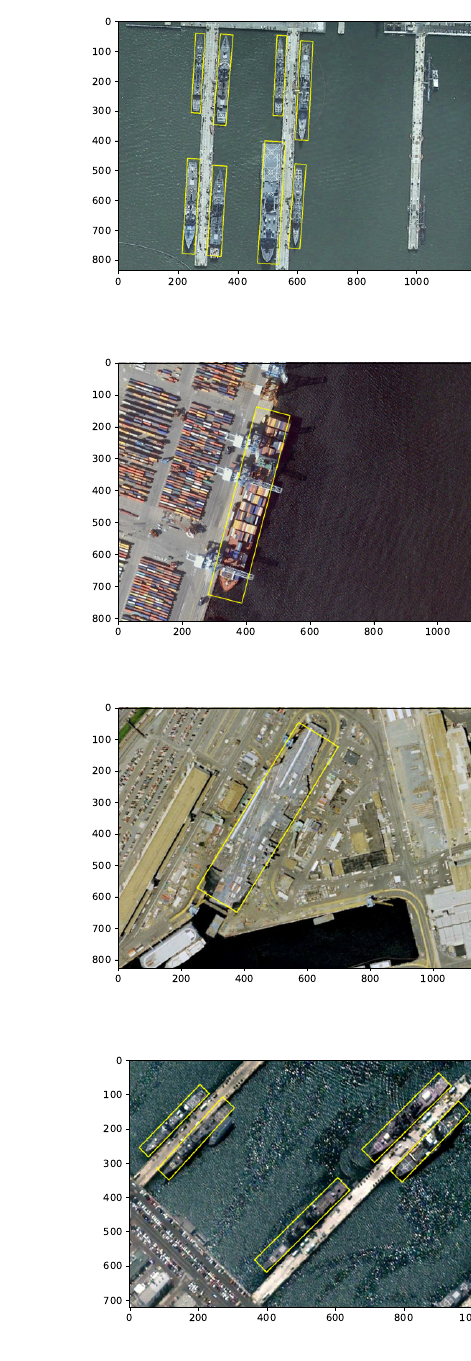
Figure 9. Visualization of detection results from CPS-Det on HRSC2016